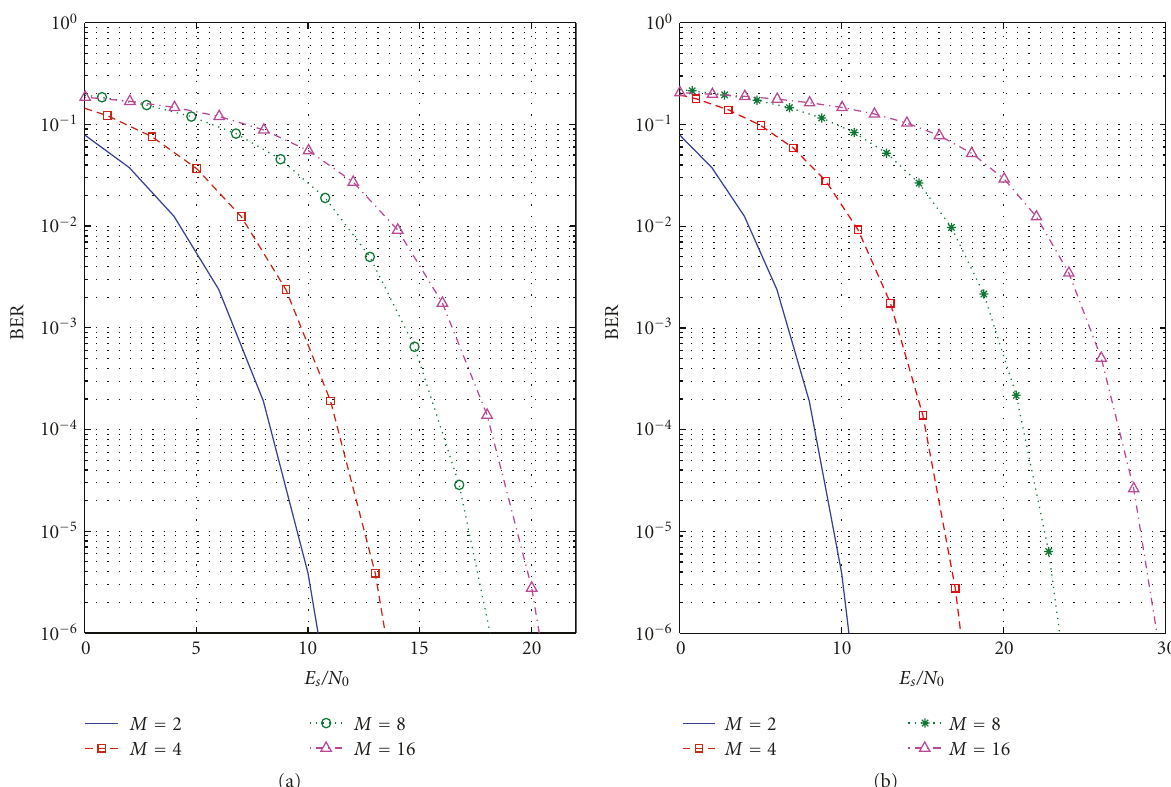
Figure 10: BER performance for di ff erent modulation orders in the AWGN channel for (a) QAM (b) PAM.